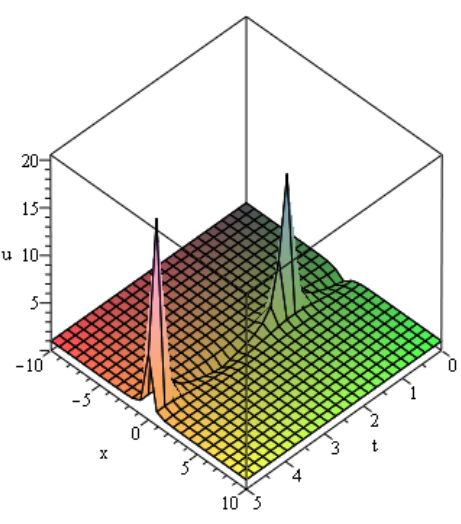
Fig. 1: The solution of Eq. (1) ( | u | ): α = 0.95; k = −2; −10 ≤ x ≤ 10;0 ≤ t ≤